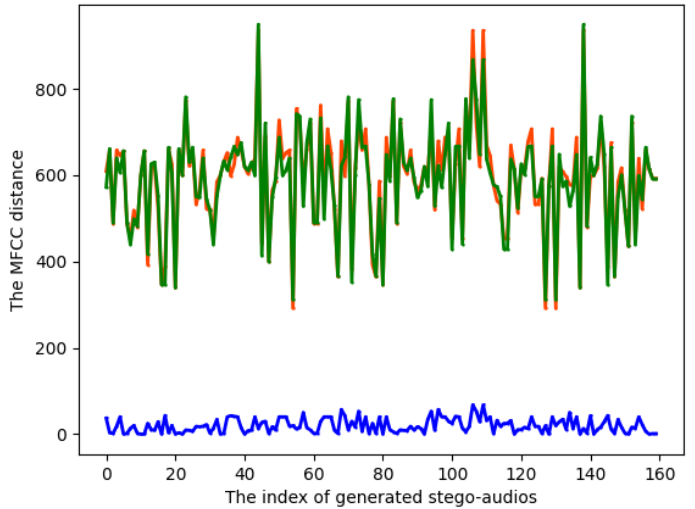
Figure 10. The Euclidean distances between the MFCCs of each stego-audio and the nearest neighbor in the training dataset as well as its nearest neighbor in the test